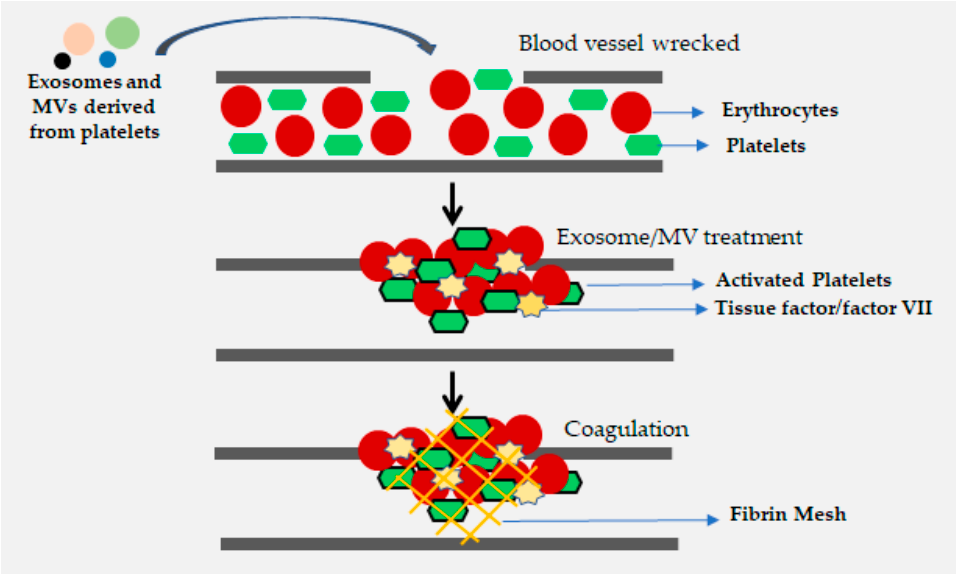
Figure 3. Enhanced coagulation via exosomes and MVs derived from platelets through tissue factors.